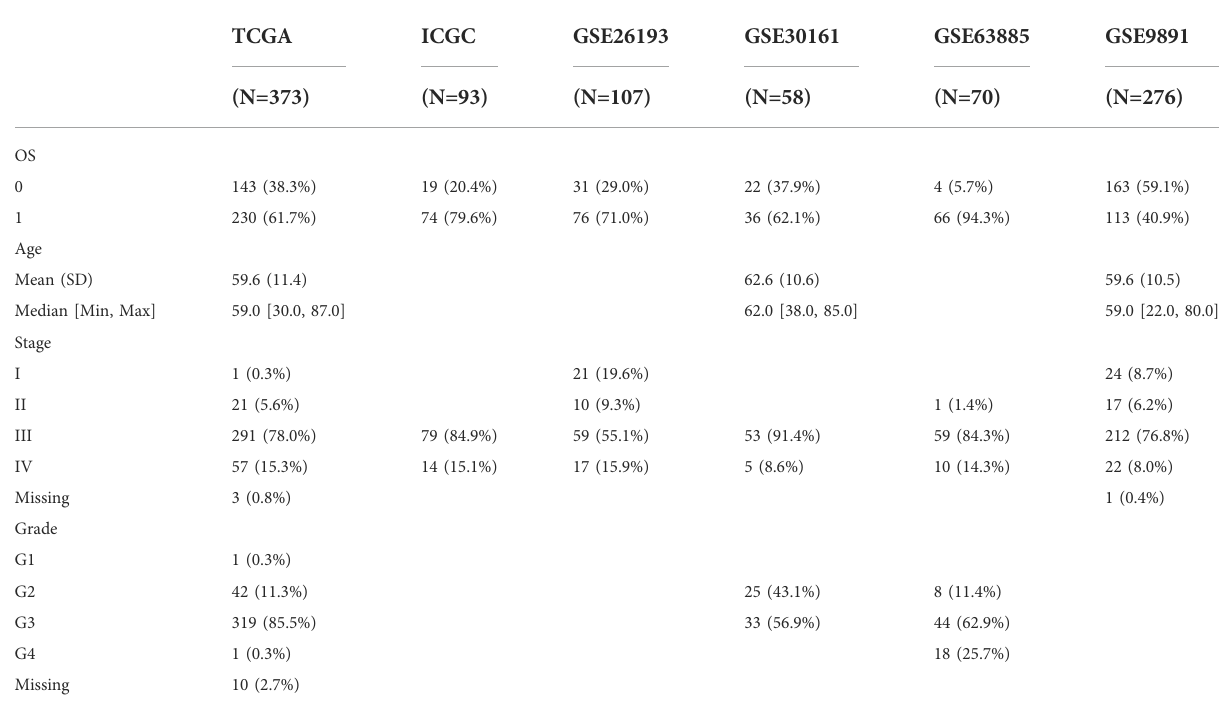
TABLE 1 The clinical features of